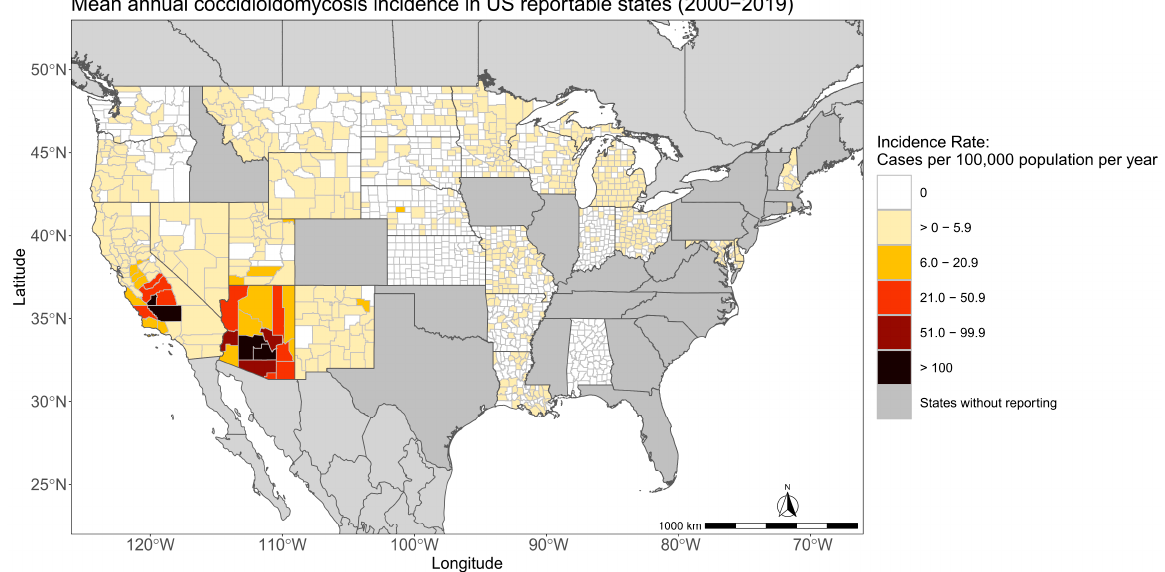
Figure 1. States in the US where coccidioidomycosis is a reportable disease have case incidence in color. Coccidioidomycosis is not reportable in gray states.